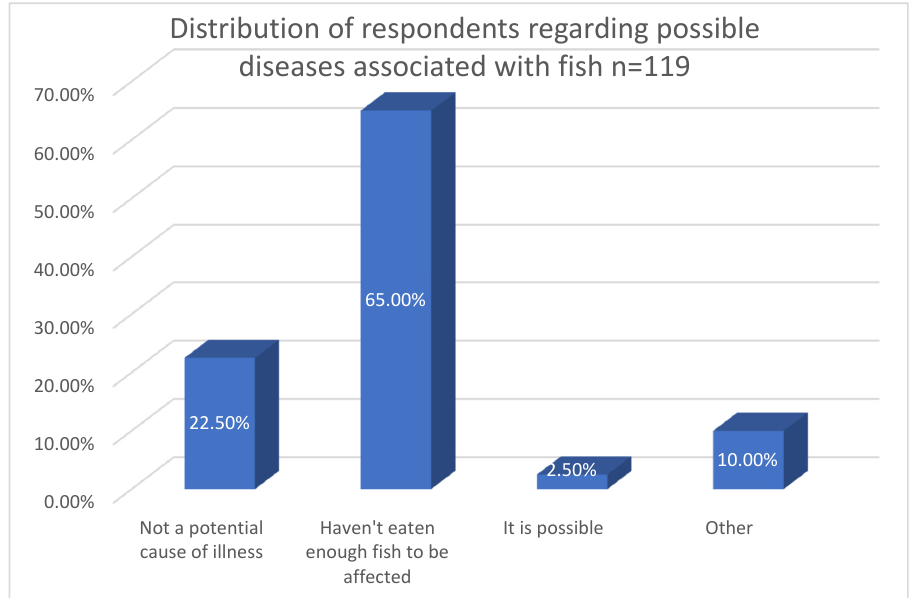
Figure 8. Distribution of respondents regarding possible diseases associated with fish consumption.